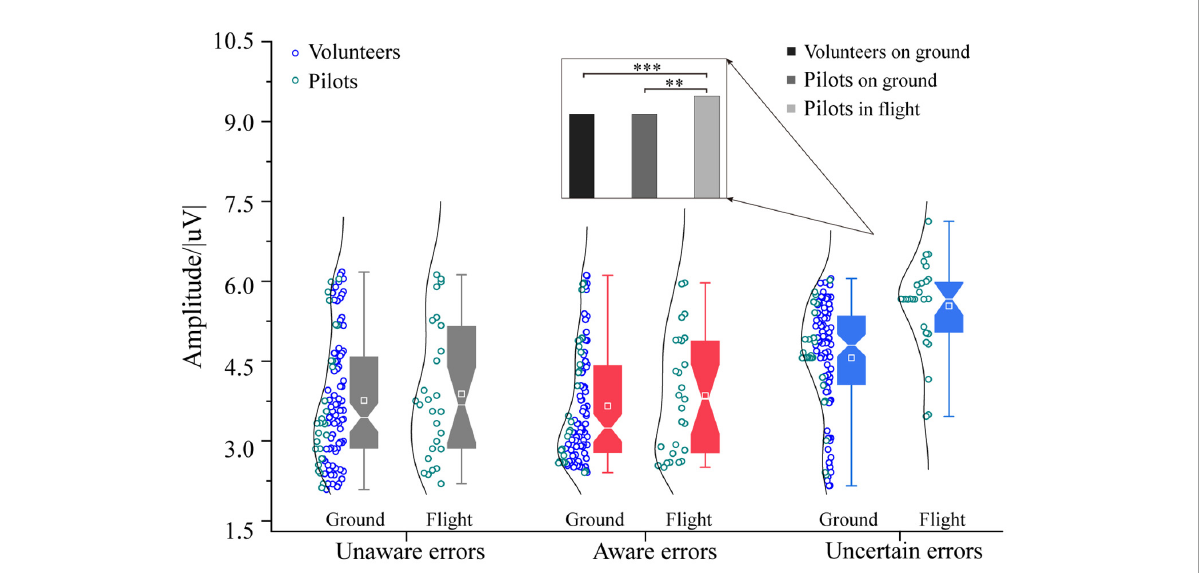
FIGURE6 Differences in Pe (300–400) between pilots and volunteers in multiple error awareness on the ground or in flight environment. The squares in the box plots indicated the mean values, the white horizontal lines indicated the medians, and both ends indicated the maximum and minimum values ( ∗∗ p < 0.001, ∗∗∗ p < 0.0001).